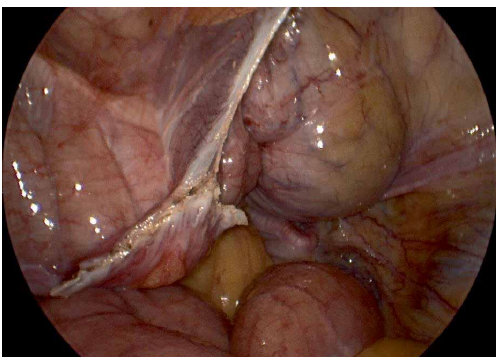
Figure 4: View of the pelvis following suprapubic drainage of the bladder, as well as the hemostatic site of lysis of adhesions (white), and colon on the left side.